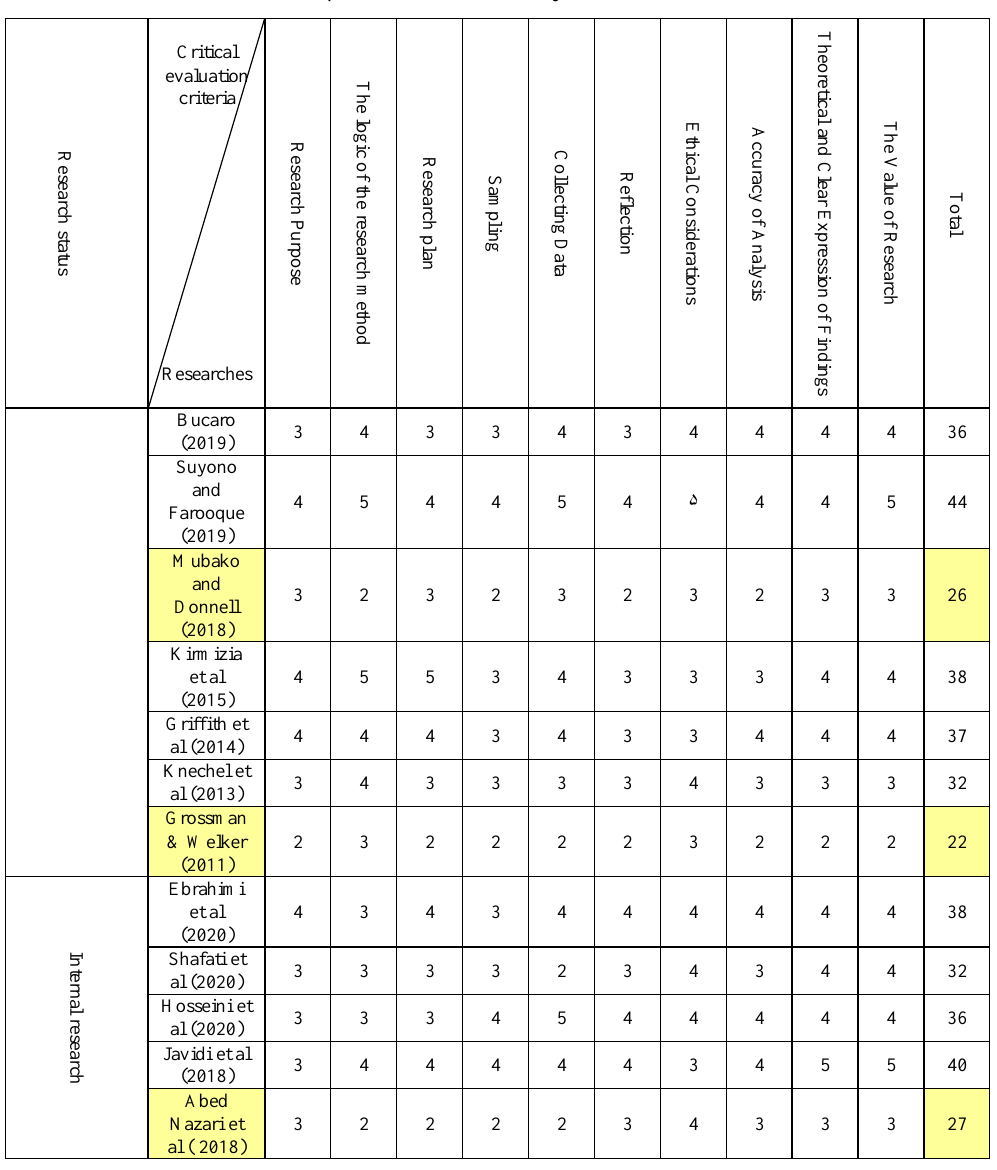
Table 4. The process of critical analysis of screened